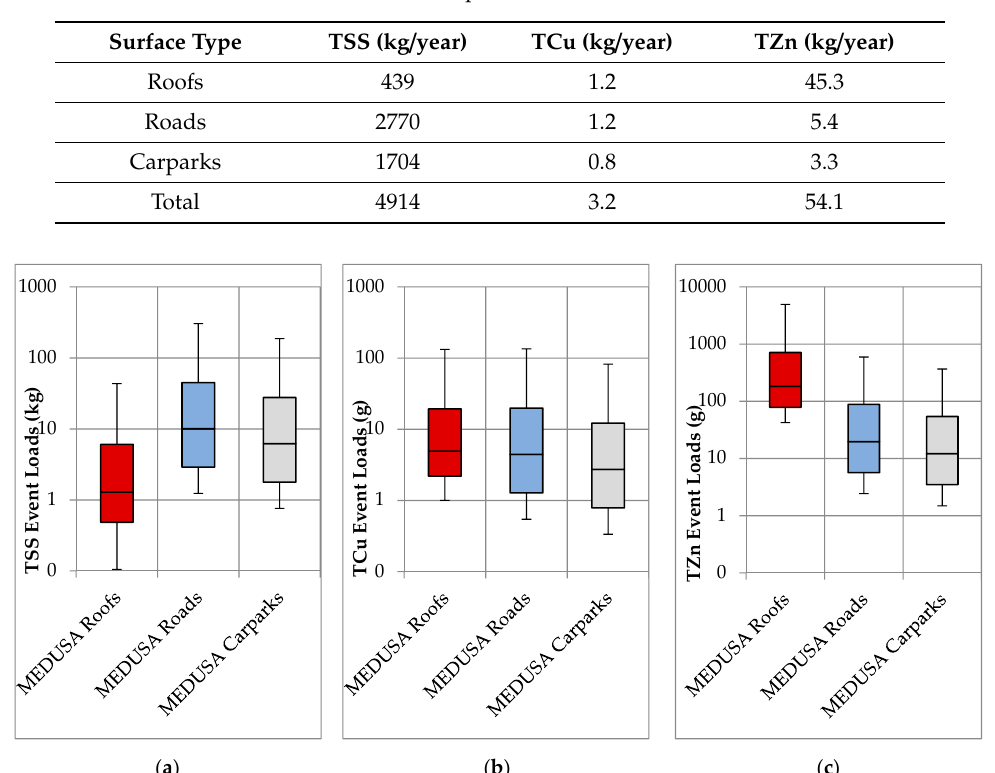
Table 4. Predicted total annual pollutant loads in Okeover catchment.